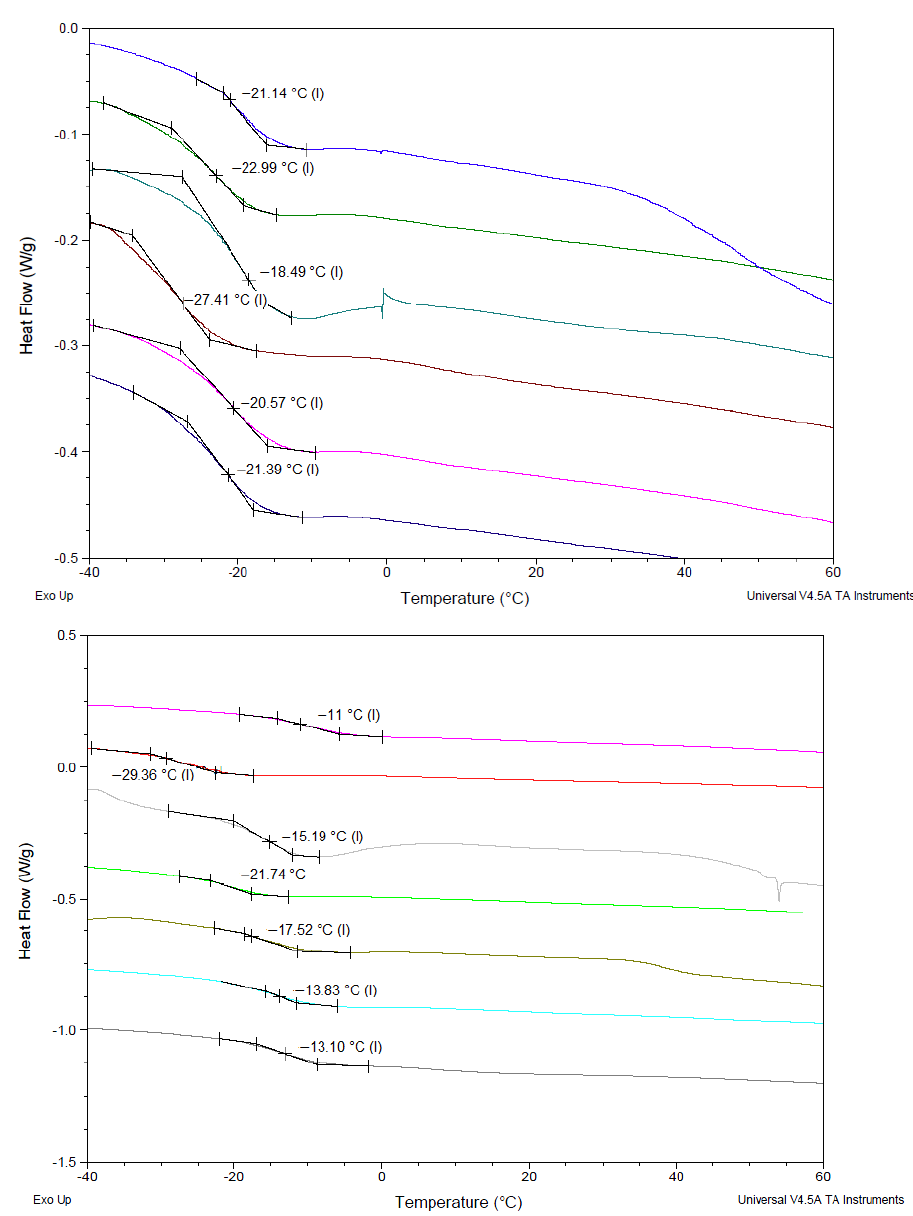
Figure 2. DSC thermograms of the DPZ ILs. The Tg values of DPZ-adipic acid, DPZ-azelaic acid, DPZ-glutaric acid, DPZ-itaconic acid, DPZ-maleic acid, DPZ-malic acid, DPZ-phthalic acid, DPZ- pimelic acid, DPZ-sebacic acid, DPZ-succinic acid, DPZ-suberic acid, DPZ-tartaric acid and DPZ- α ketoglutaric acid were − 21.14 ◦ C, − 22.99 ◦ C, − 18.49 ◦ C, − 27.41 ◦ C, − 20.57 ◦ C, − 21.39 ◦ C, − 11 ◦ C, − 29.36 ◦ C, − 15.19 ◦ C, − 21.74 ◦ C, − 17.52 ◦ C, − 13.83 ◦ C, and − 13.10 ◦